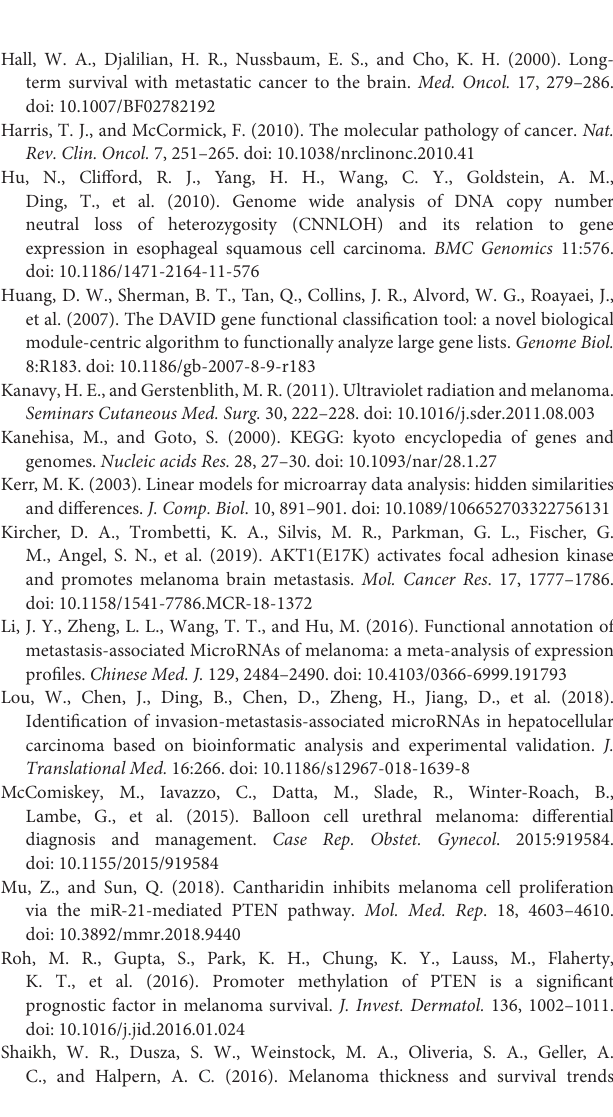
LIMMA. Supplementary Table 1 | List of differentially expressed miRNAs between MM samples and PM